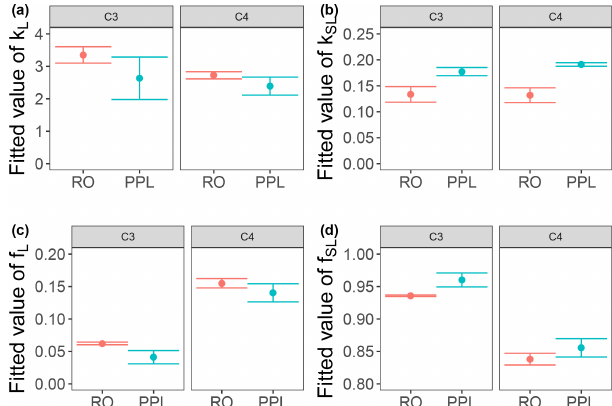
Figure 7. Fitted biexponential model parameters (Eq. 3) from the time series of the loss of PARAFAC components three and four in irradiation experiments that compare RO SRNOM to PPL SRNOM (see Fig. 6 for data). f is unitless, and k is square meters per mole of photons. C 3 and C 4 denote PARAFAC components three and four. Error bars represent the mean and standard deviation from the three experiments. The two-tailed t tests suggest differences in k SL for both components ( p = 0 . 020 in component three; p = 0 . 015 in component four), while f L and f SL may differ ( p = 0 . 065